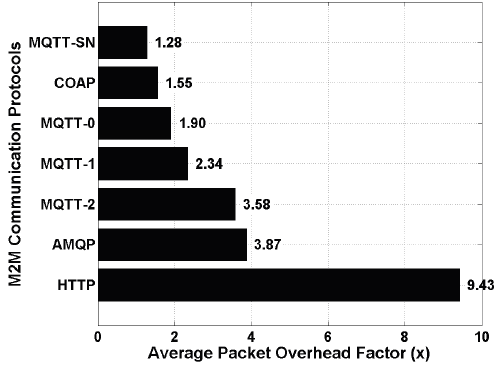
Figure 9. Performance of M2M Communication Protocols—Total Amount of Exchanged Packets (The following libraries were used for the implementation of all these M2M protocols: (1) Mosquitto 1.1.3 for the MQTT broker and Eclipse PAHO for the MQTT client; (2) RabbitMQ 3.0.4 for the AMQP Broker and Client; (3) Californium 0.8.4 for the COAP server and LibCoap 4.0.1 for the COAP client; (4) ruby-em-mqtts for the MQTT-SN server and client; and finally (5) Apache v2 for the HTTP server and client).